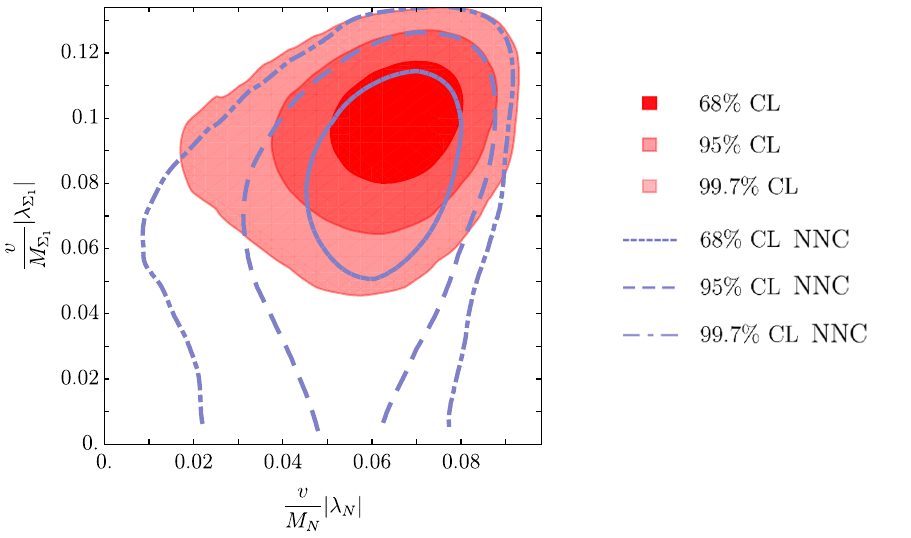
Figure 9 . Global fit with one generation of the VLL N coupling to electrons and one generation of the VLL Σ 1 coupling to muons. The red regions are proffered at the 68%, 95% and 99.7% C.L. and the lines indicate the effect of including the